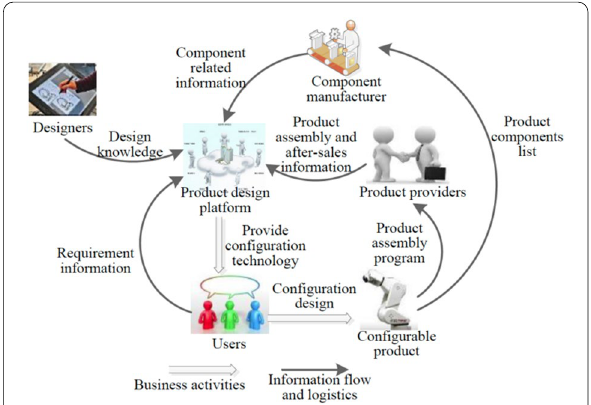
Figure 3 Scene of user-participation configuration design [49]